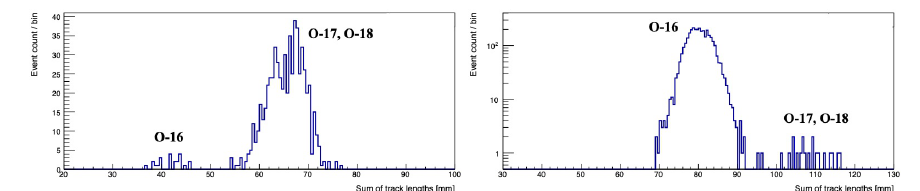
Figure 2. Identification plot, based on the sum of the α and 12 , 13 , 14 C track lengths for two-particle events at E γ = 8.66 MeV (left) and 11.5 MeV (right). Partial statistics and laboratory reference frame.